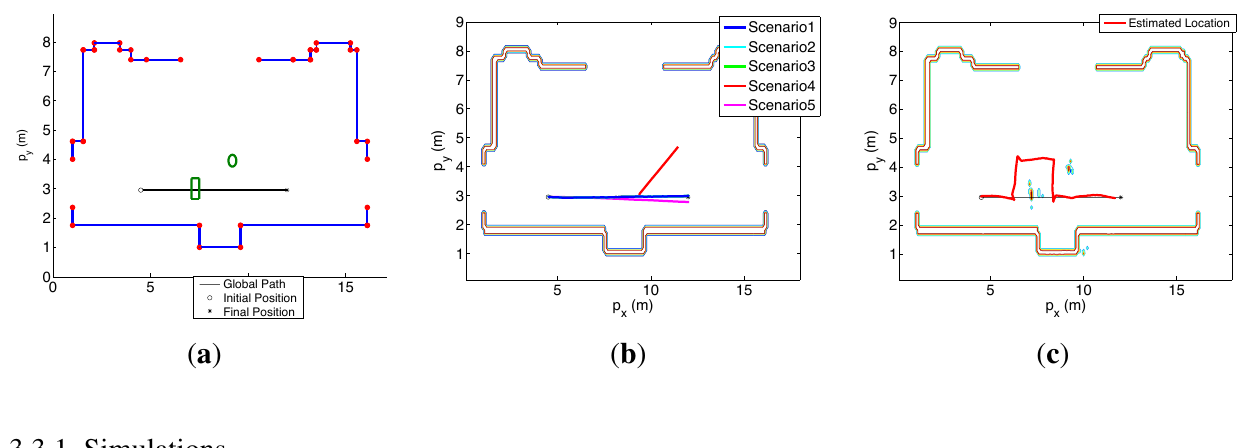
Figure 5. Experiments Setup. ( a ) Map Objects; ( b ) Simulated Experiment; ( c ) Real